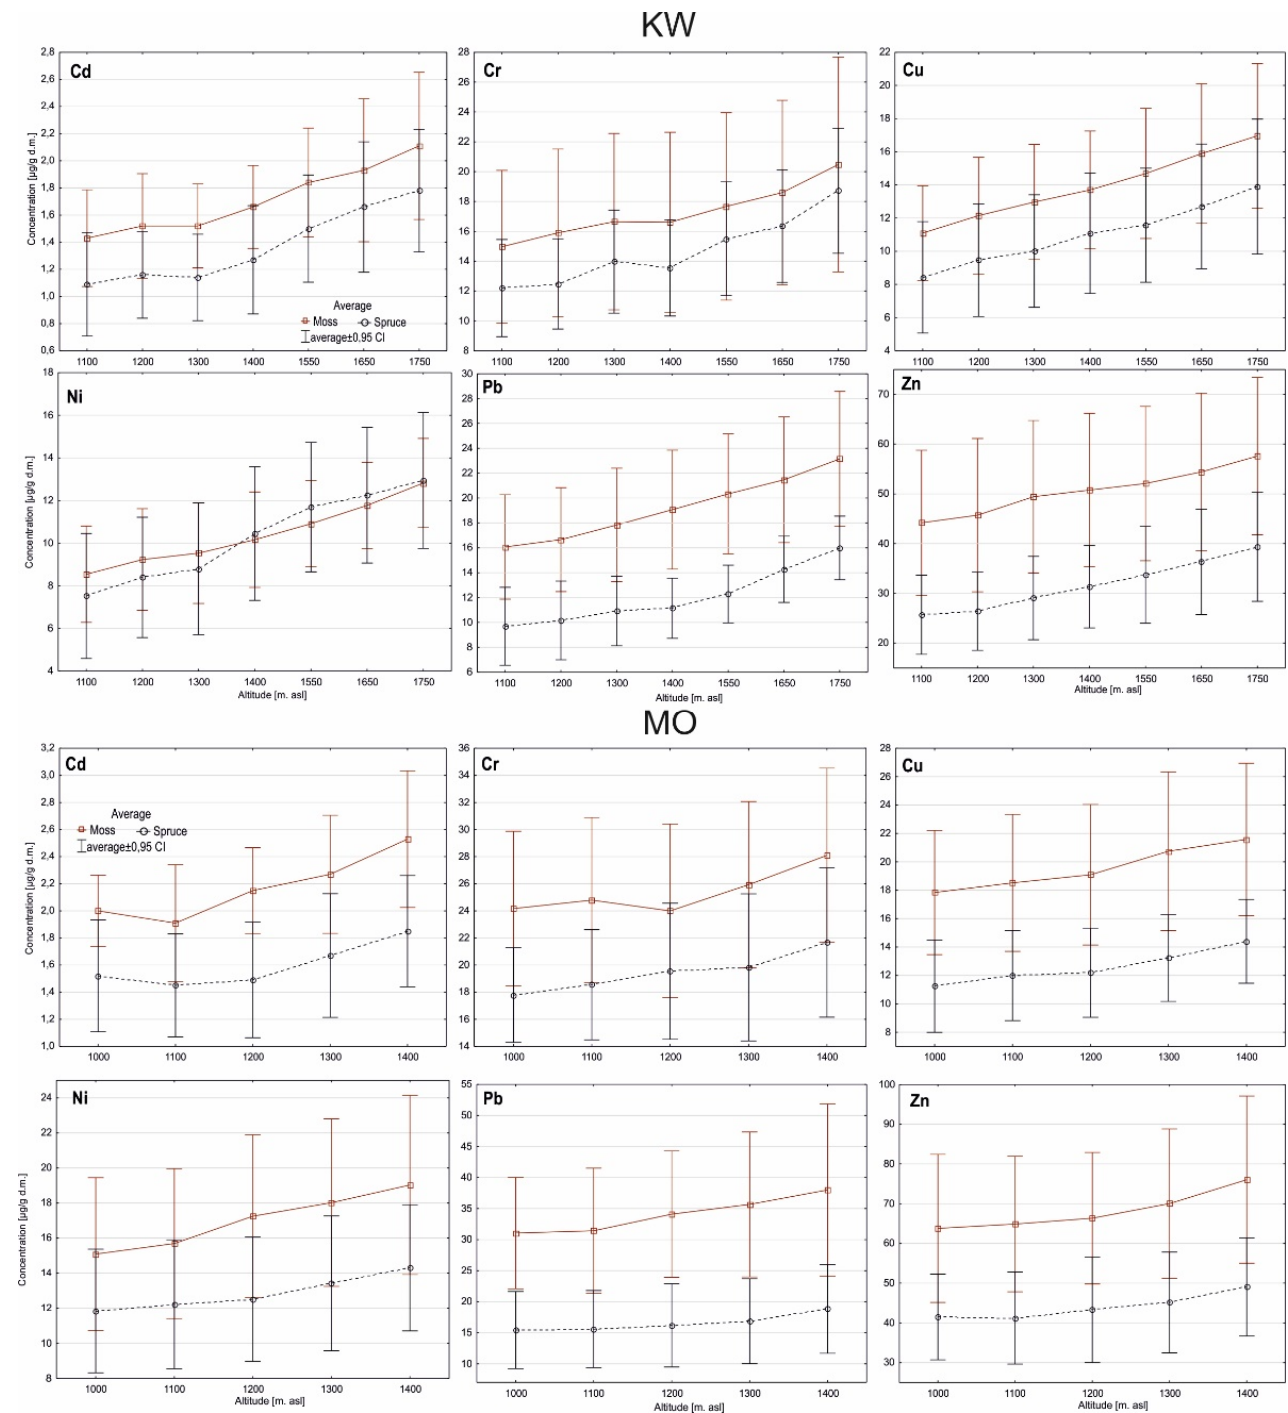
Figure 2. Mean metal content in plants ( Pleurozium schreberi and Picea abies ) in Tatra National Park, Poland. Confidence intervals for 95% of observations.